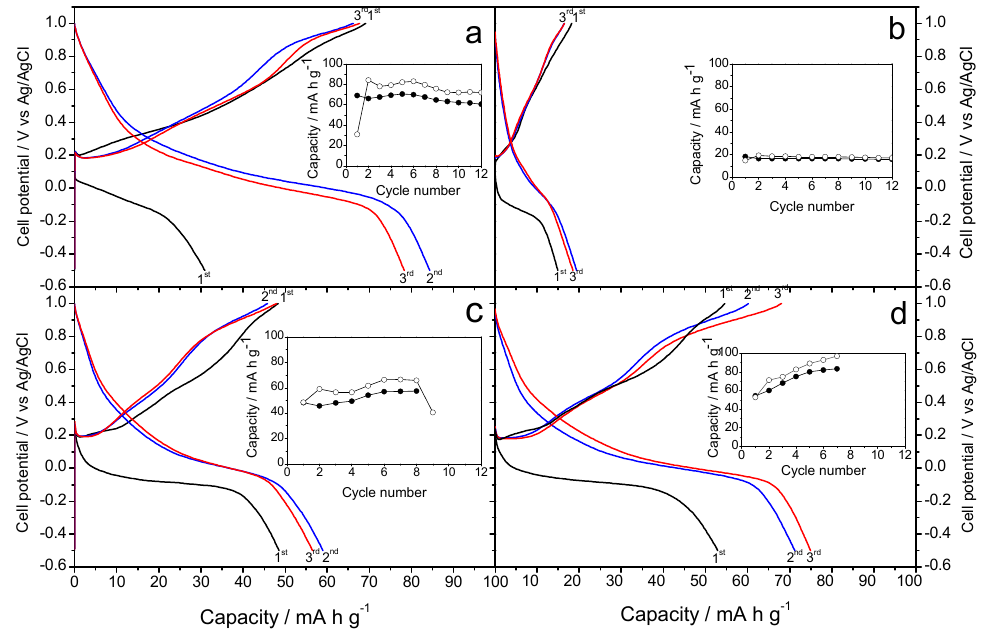
Figure 7. Galvanostatic curves in aqueous MgSO 4 -based electrolyte recorded at C / 8, referring the voltages to the Ag / AgCl electrode and starting with discharge: ( a ) Na-B / SS ( b ) Na-B / HT ( c ) K-B / SS ( d ) K-B / HT. Insets: capacity vs. cycle number (open circles: discharge, filled circles: charge).